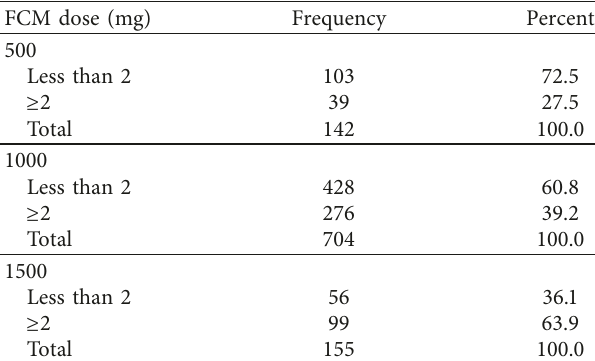
Table 4: Proportion of patients with a change of ≥ 2g/dl in blood hemoglobin by FCM